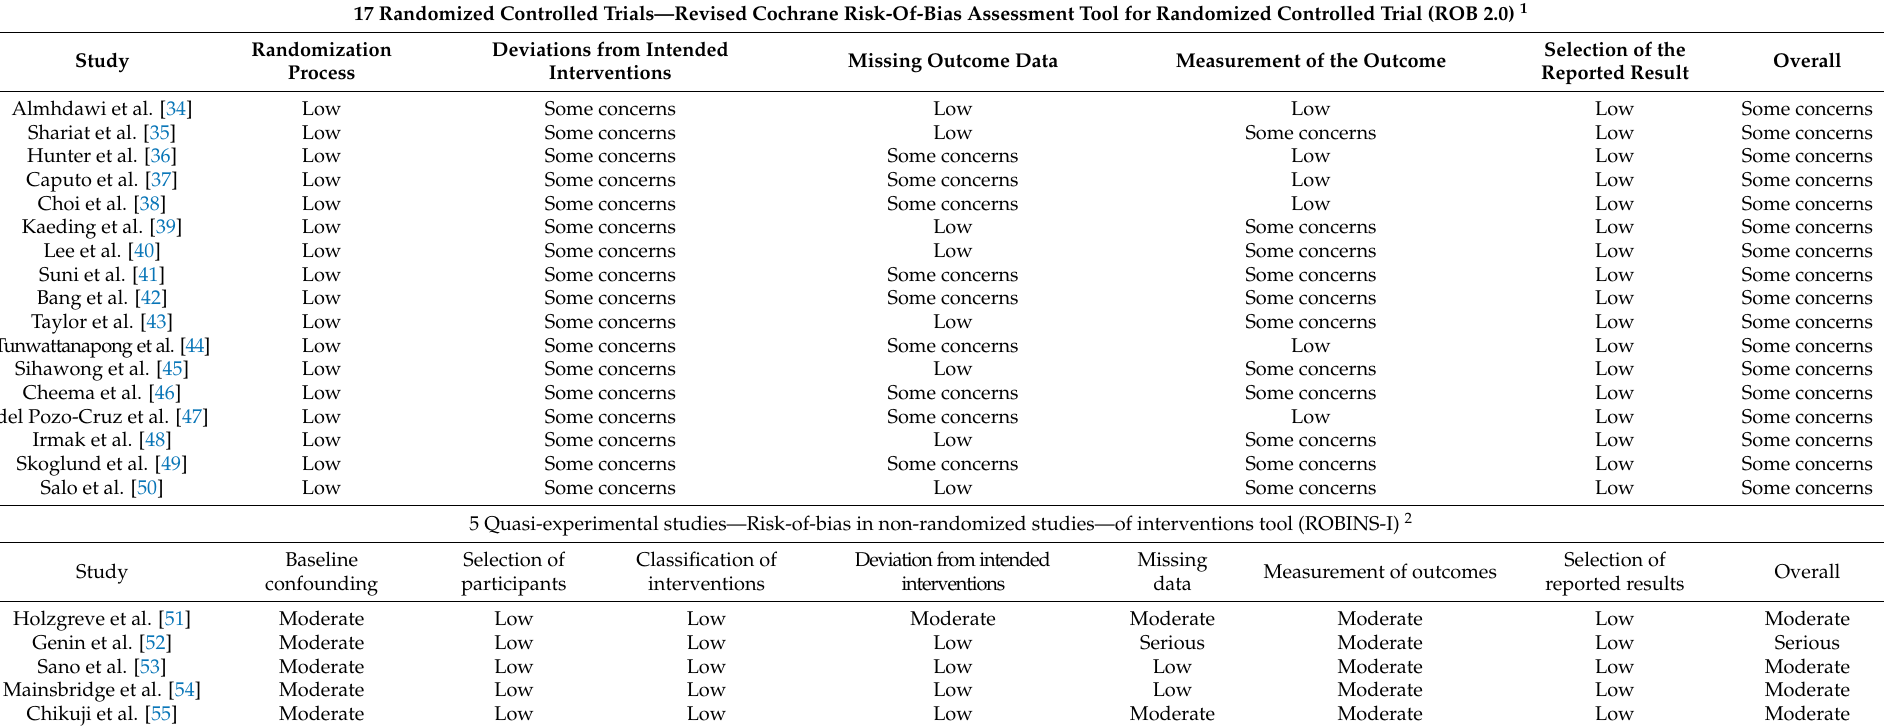
Table A4. ROB assessment of the included